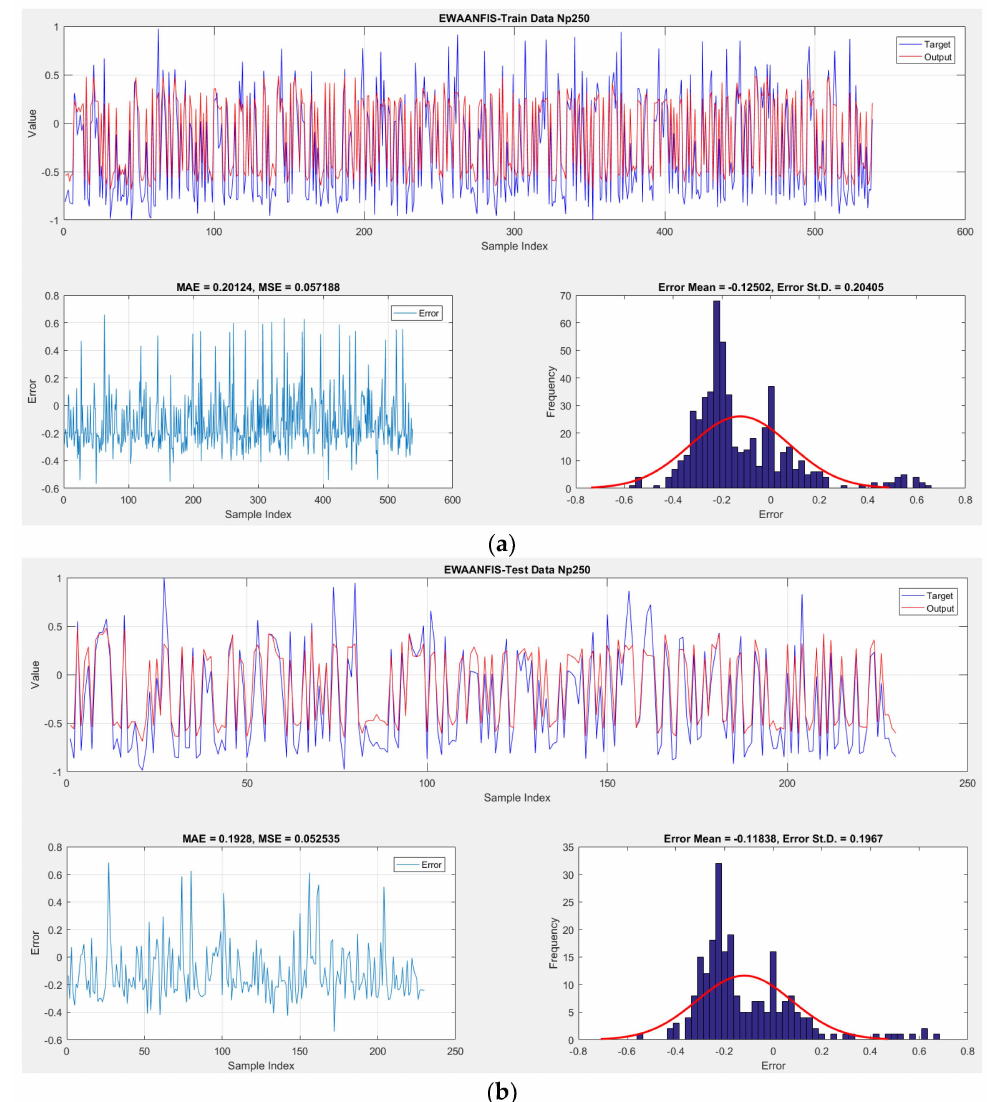
Figure 8. Frequency and minimum value of errors in EWAANFIS best-fit structure: ( a ) training dataset; ( b ) testing